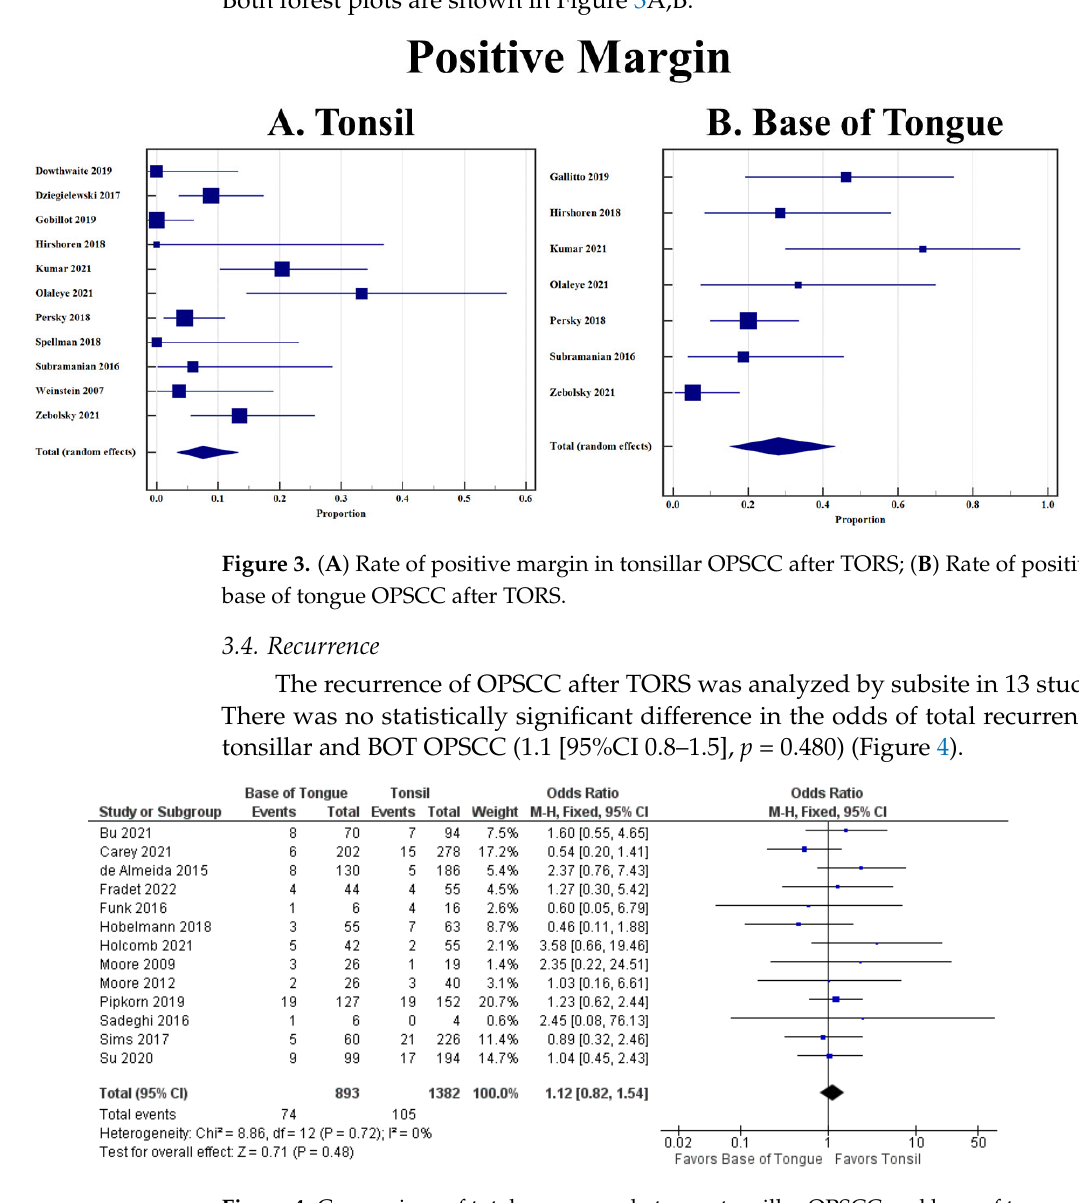
Figure 5. Comparison of locoregional recurrence between tonsillar OPSCC and base of tongue OP ‐ SCC. Figure 6. Comparison of metastatic recurrence between tonsillar OPSCC and base of tongue OP ‐ SCC. 3.5. Hemorrhage Postoperative hemorrhage was described by subsite in nine articles for this review [26–28,32,34,44,50–52]. There was no statistical difference between the hemorrhage rates